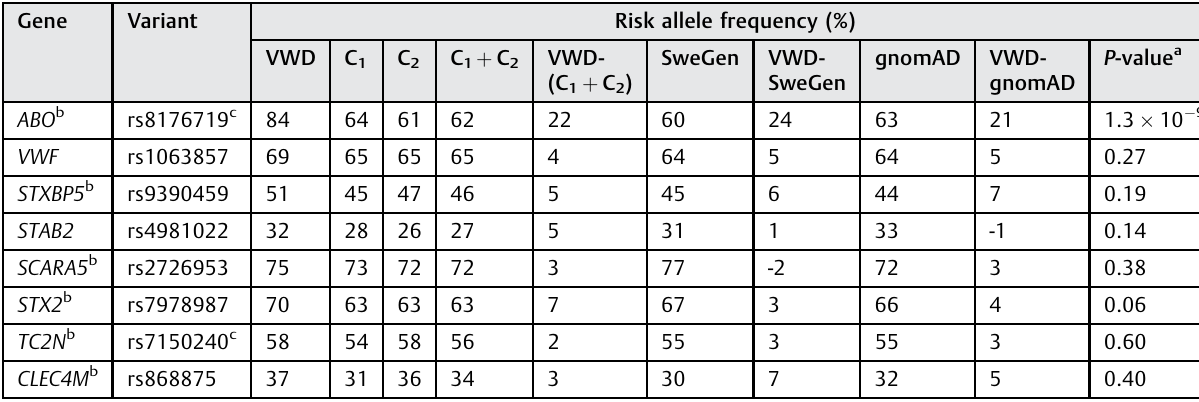
Table 1 Comparison of allele frequencies between VWD and local control (C 1 and C 2 ): SweGen and the non-Finnish European gnomAD